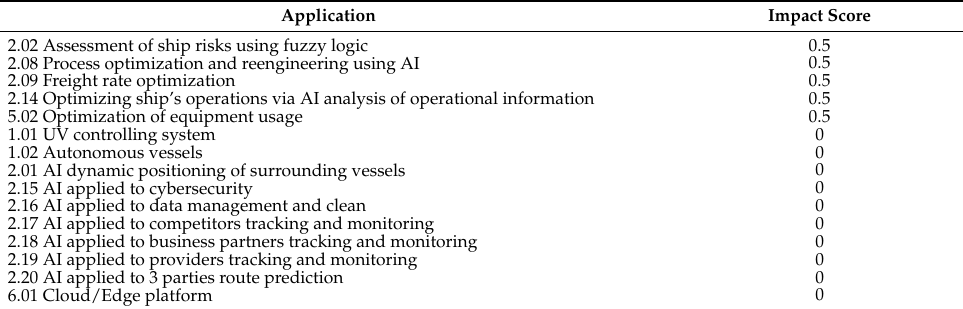
Table 7. Bottom applications on Time performance